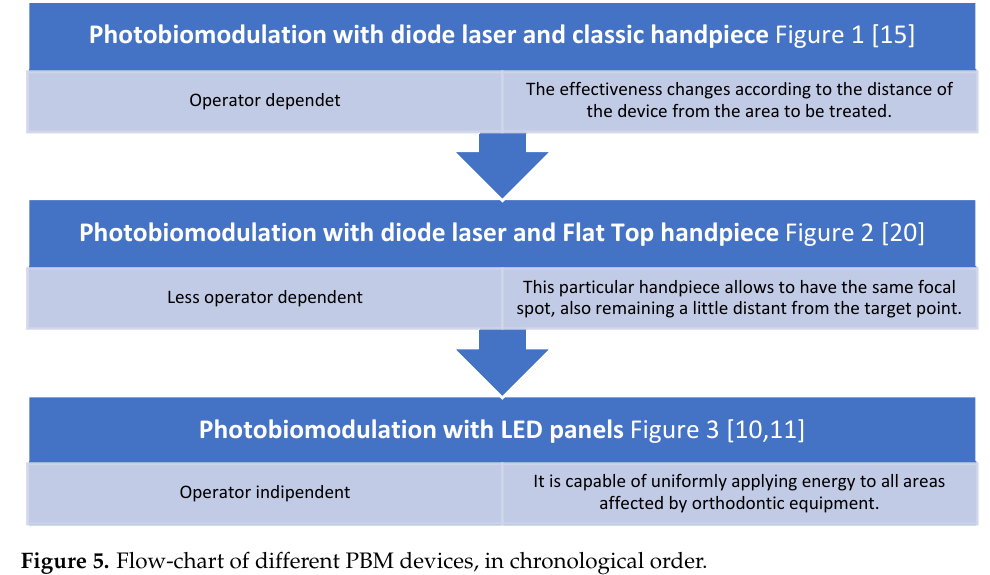
Figure 4. Difference between laser and LED light beams.